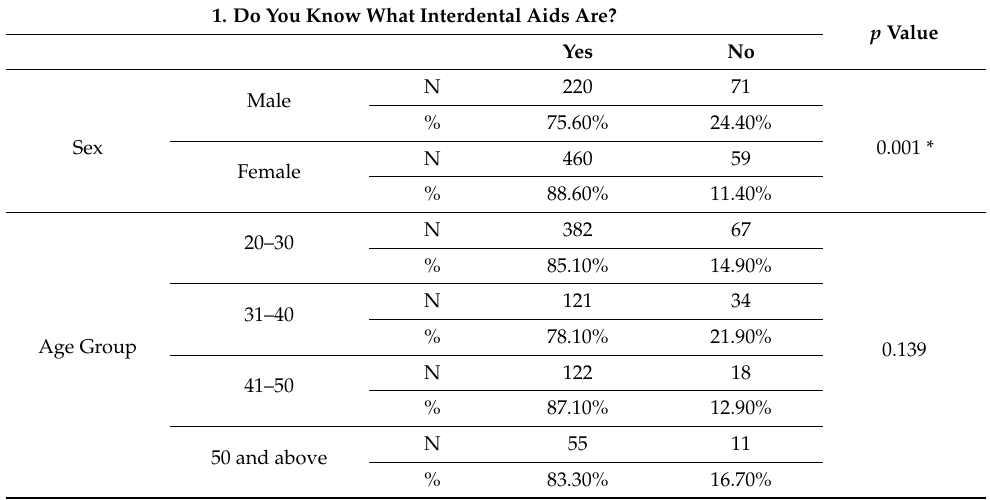
Table 5. Perception and knowledge of different parameters on “Do you know what interdental aids